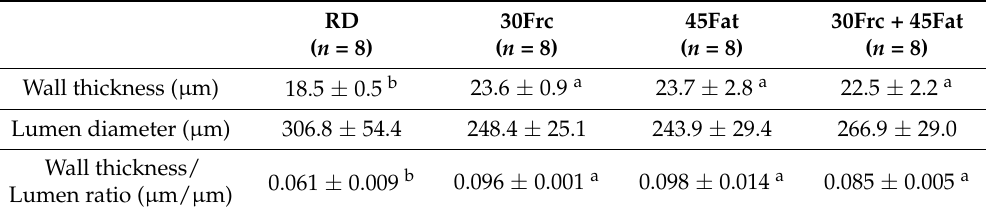
Table 6. Abdominal aorta wall thickness and lumen